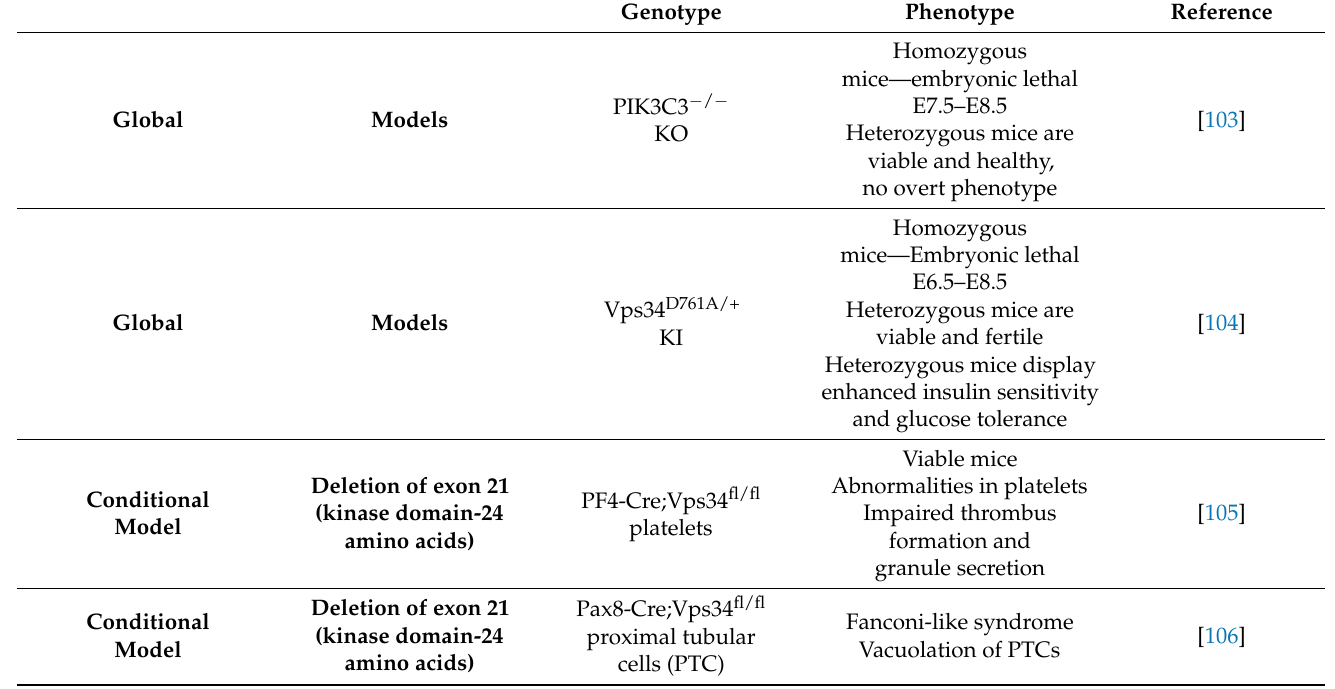
Table 2. Genetically engineered mouse models of class III